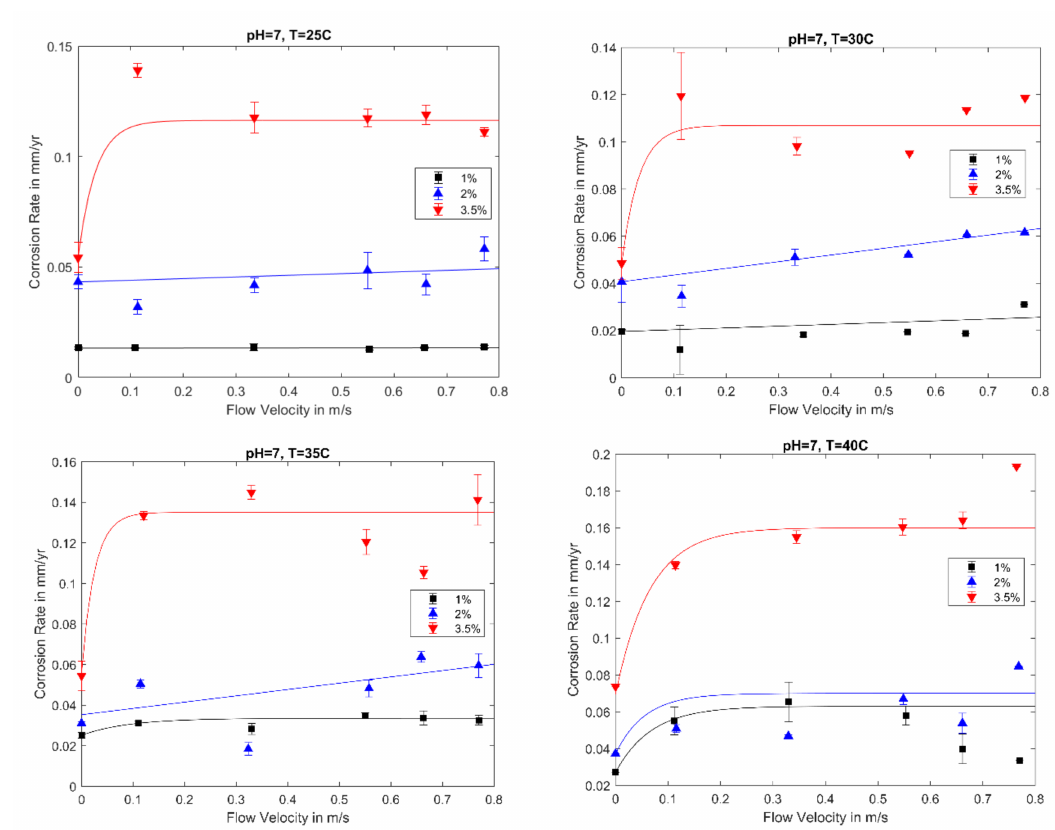
surface when there is no flow. It can be observed from Figure 8, that at pH-7, the corrosion rate varies from 0.0254 mm/yr to about 0.2032 mm/yr when the NaCl concentrations vary from 1% to 3.5%. At a temperature of 25 ◦ C, the corrosion rate is less than 0.0254 mm/yr for 1% NaCl concentration and the corrosion rates reach 0.0508 mm/yr and 0.1143 mm/yr at 2% and 3.5% NaCl, respectively. A corrosion rate of 0.0558 mm/yr is observed for 2% NaCl solution at 30 ◦ C, and 0.0635 mm/yr at 35 ◦ C. At 40 ◦ C, the corrosion rates increase from 0.0508 mm/yr to 0.08636 mm/yr when NaCl concentration changes from 1% to 2%. Corrosion rate further increases and reaches a value of 0.1727 mm/yr is at 3.5% NaCl concentration.